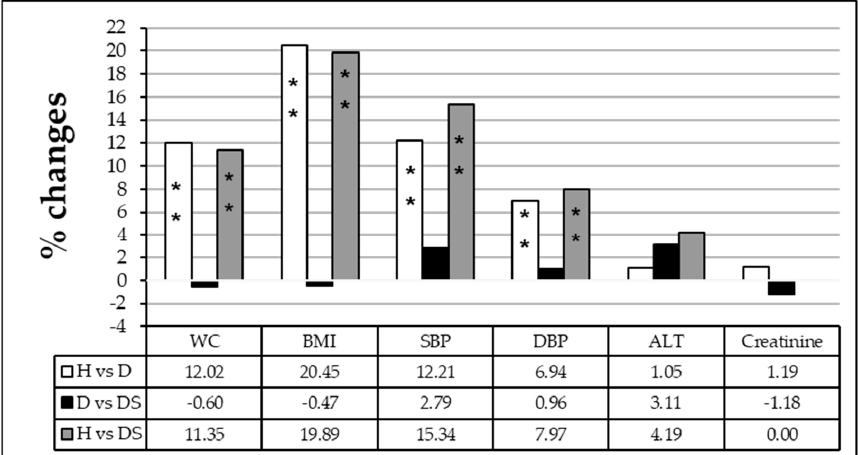
Figure 1. Percentage of change in waist circumference (WC), body mass index (BMI), systolic blood pressure (SBP), diastolic blood pressure (DBP), alanine transaminase (ALT) activity, and creatinine level among healthy individuals (H), diabetic patients (D) and diabetic patients sweetener consumers (DS). The comparison was performed using one-way ANOVA. Values presenting p > 0.05 were considered non-significant (NS). Significant values are represented by * p < 0.05 and ** p <0.001. Serum fasting glucose and HbA1C results presented a significant increase (112.81 and 64.79%) in group D when compared to group H ( p < 0.001). Further significant increases in FSG (17.51%) were observed in the DS group as compared to the D group (Figure 2).